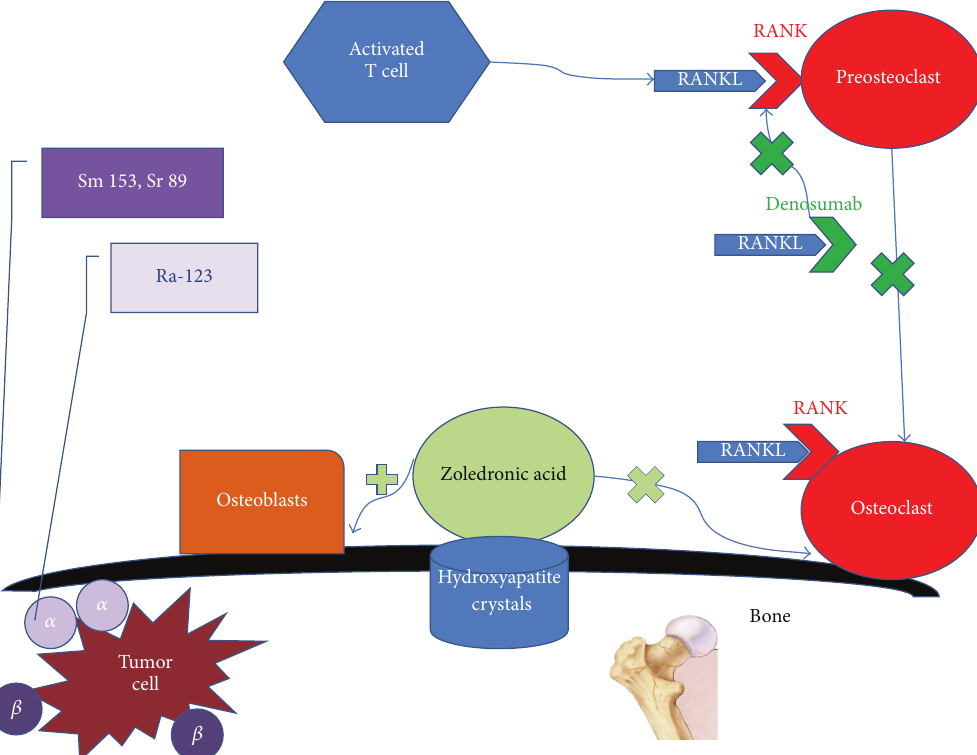
Figure 1: Simplified figure of selected bone-targeted therapies in mCRPC and their targets. Zoledronic acid binds to hydroxyapatite crystals preventing the activity of osteoclasts and stimulating osteoblast. Denosumab binds to RANKL preventing the binding of RANKL to RANK